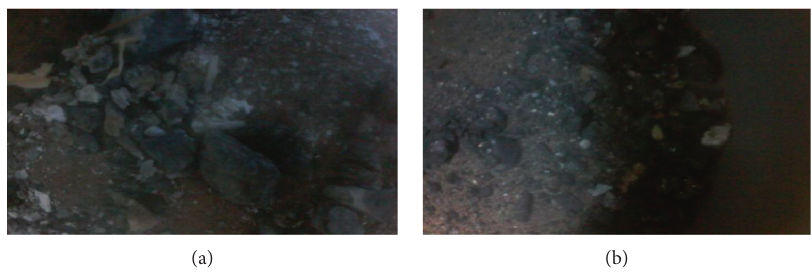
Figure 6: Drained material from FBC after combustion. (a) Mui and (b) Taru